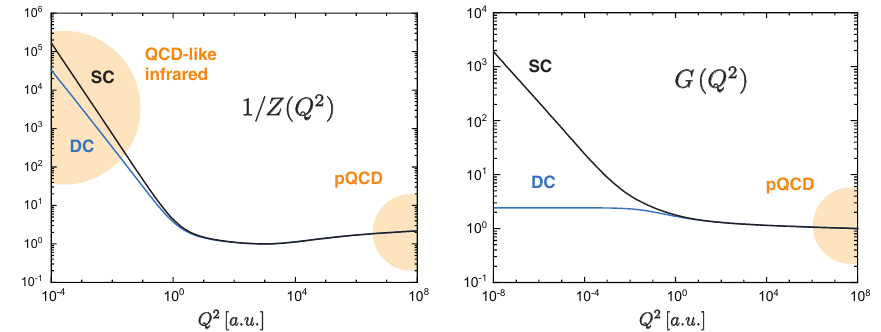
Figure 1: DSE solutions for the inverse gluon dressing function 1 / Z ( Q 2 ) and ghost dressing function G ( Q 2 ) , where ‘DC’ denotes decoupling and ‘SC’ scaling [ 5 ] . corresponds to Landau gauge. In linear covariant gauges, the longitudinal dressing